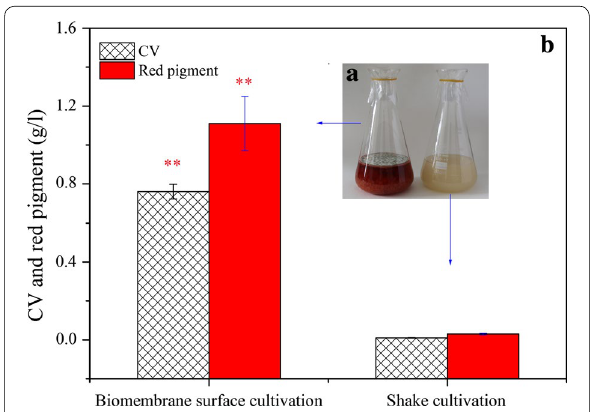
Fig. 1 Shake cultivation and biomembrane surface cultivation for production of red pigments of P. novae - zelandiae . a Color comparison and b the maximum color value (CV) and concentration of red pig- ment on day 8